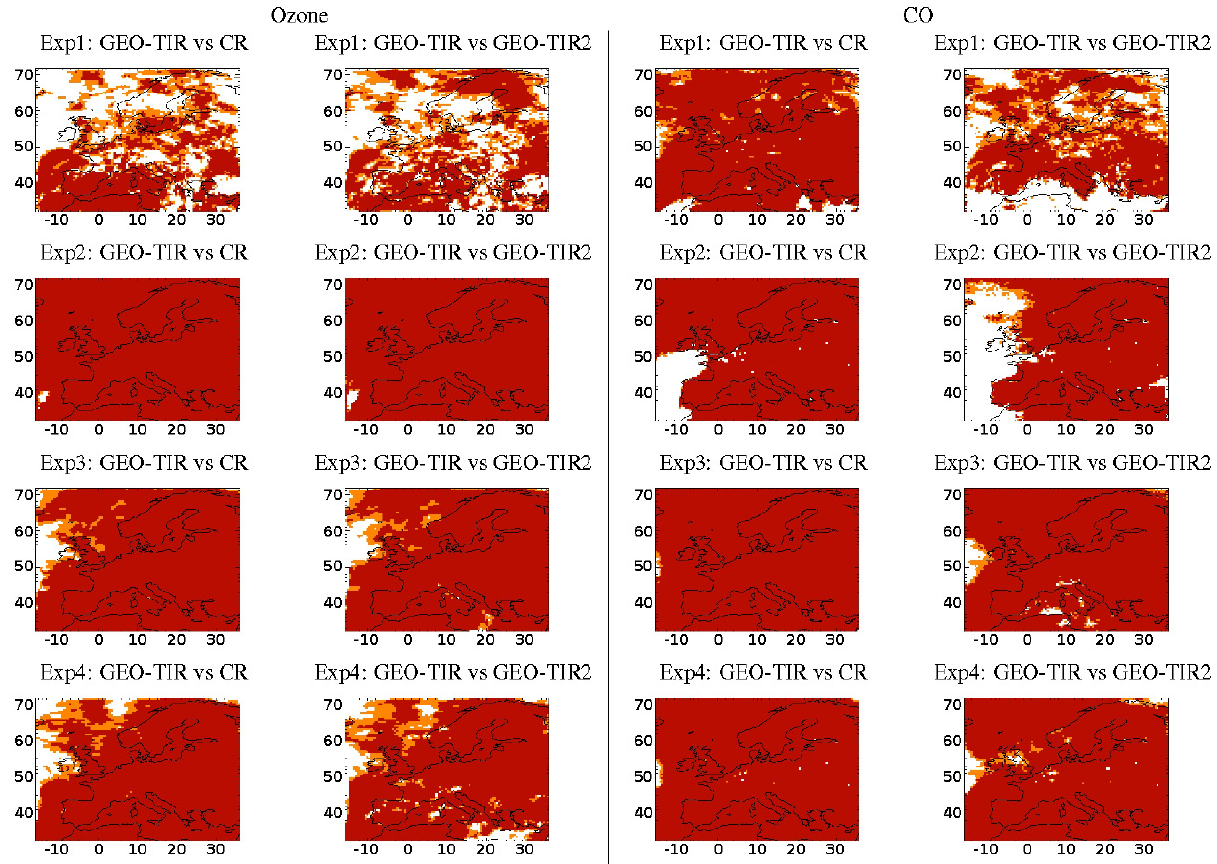
Fig. 4. 1st and 3rd column: z -test where the absolute difference between GEO-TIR and the NR, and between the CR and the NR are different at the 0.95 confidence level (orange and red) and 0.99 confidence level (red) for Ozone and CO LmT column, respectively. 2nd and 4th: same as 1st and 3rd column but for the absolute difference between GEO-TIR and the NR, and between the GEO-TIR2 and the NR. The 1st row is for EXP1 (change in the meteorology), the 2nd row is for EXP2 (change in the emissions), the 3rd row is for EXP3 (change in the initial condition) and the 4th row is for EXP4 (change in the meteorology, in the emissions and in the initial condition). See text for further